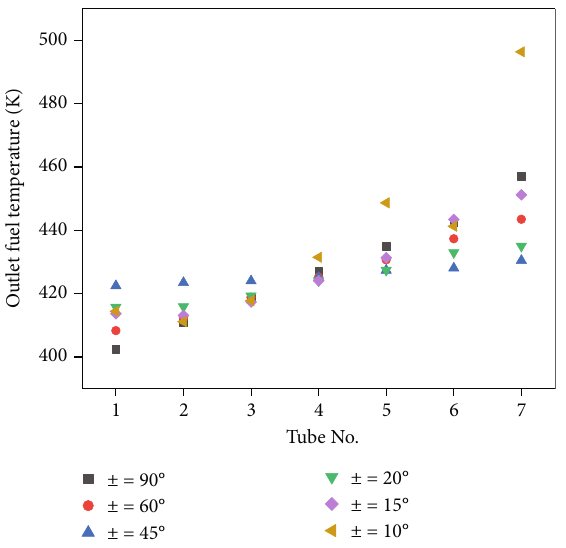
Figure 11: Nonuniformity coe ffi cient with di ff erent HW